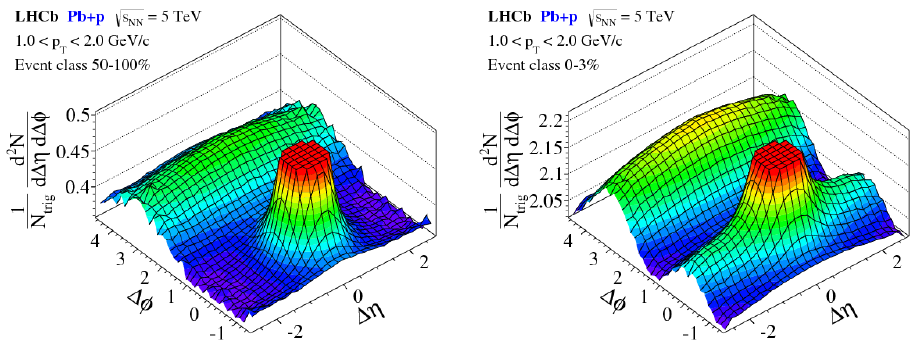
Figure 1. Correlation functions for Pb p collisions at low (left) and high (right)